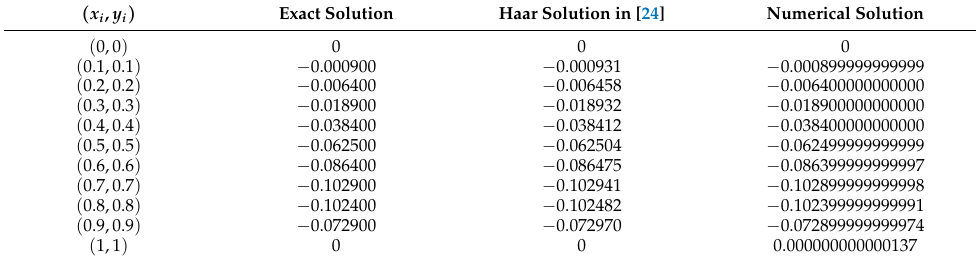
Table 6. The numerical results in Example 3.